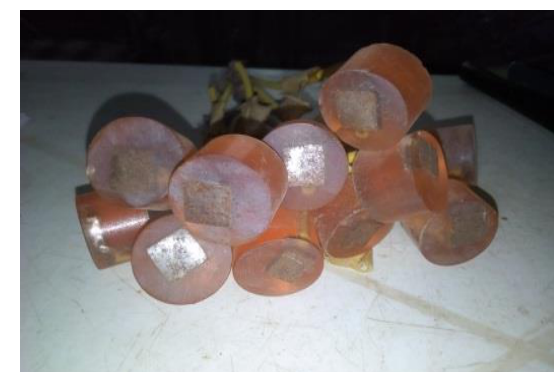
Figure 5: Specimens held in foil and connected with cable for electrochemical